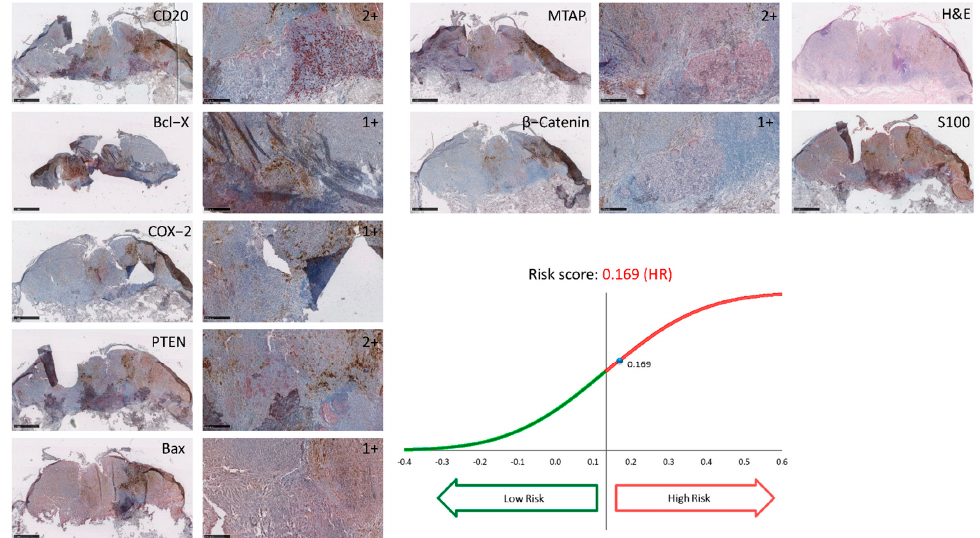
Figure 1. Immunohistochemical staining and risk score stratification Patient A. 1+: weak cytoplasmic staining or less than 20% of cell nuclei stained; 2+: moderate cytoplasmic staining or 21 to 50% of cell nuclei stained. COX-2 = Cyclooxygenase-2, PTEN = Phosphatase and Tensin Homolog, Bax = Bcl-2-associated X protein, MTAP = S-methyl-5 (cid:48) -thioadenosine